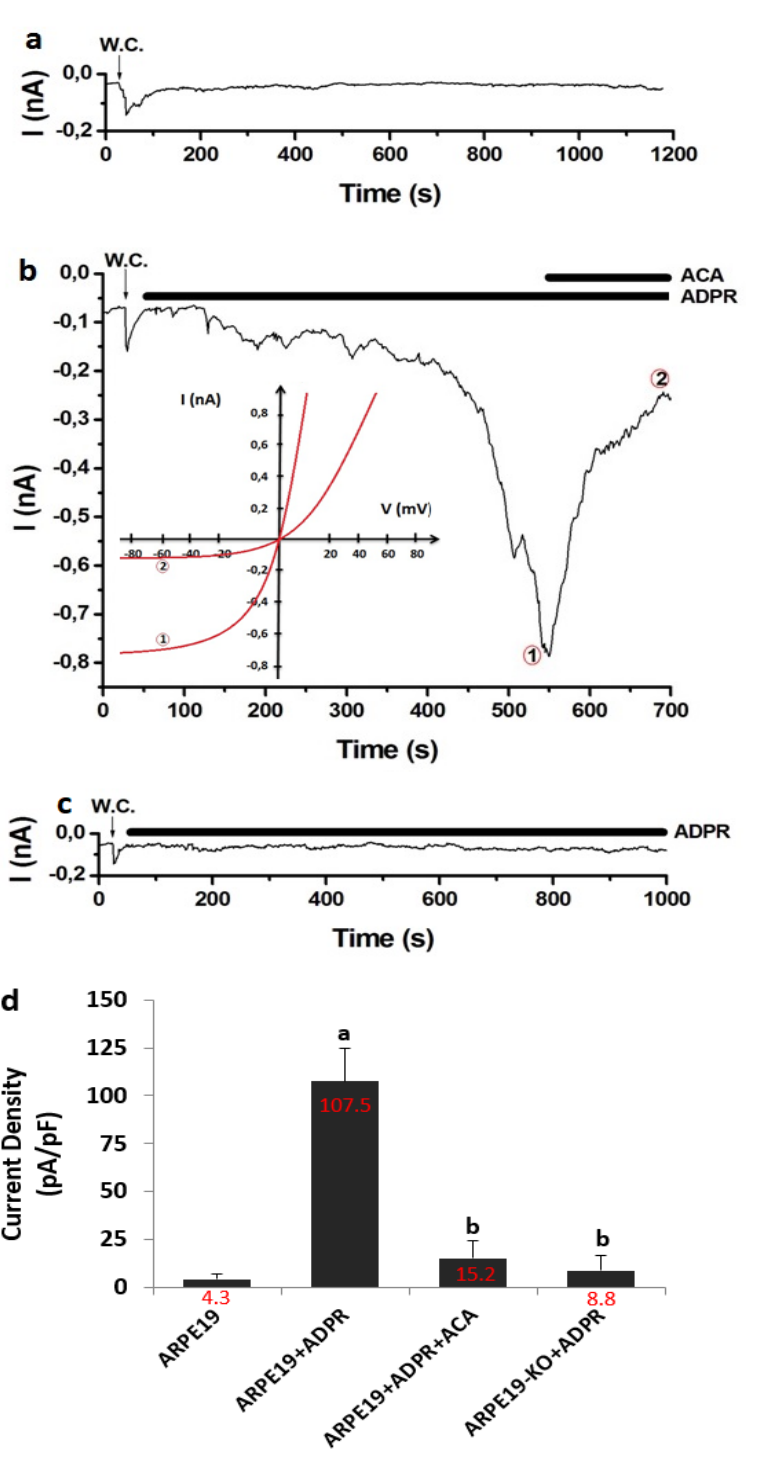
Figure 5. The stimulation of ADPR induced the activation of TRPM2 in the cells of ARPE19, but not in the cells of ARPE19-KO. (Mean ± SD and n = 6). The whole cell (W.C.) configuration current records of TRPM2 were taken in voltage-clamp (at − 60 mV) ( a ). The cells of ARPE19 without cytosolic ADPR (1 mM). ( b ). ARPE19 + ADPR group. The cytosolic ADPR (1 mM)-mediated TRPM2 currents were inhibited by ACA (25 µM). ( b ) - I/V. Time points ADPR and ACA were indicated 1 and 2, respectively. ( c ). ARPE19-KO + ADPR group. There is no cytosolic ADPR (1 mM)-mediated TRPM2 current. ( d ). The mean current densities from the cells of ARPE19 and ARPE19-KO. ( a p ≤ 0.05 vs. ARPE19). b p ≤ 0.05 vs. ARPE19 + ADPR).